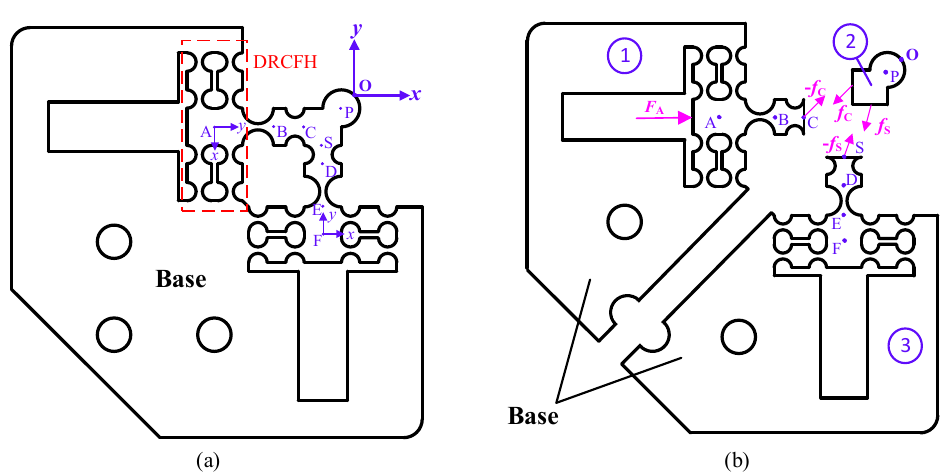
Figure 7. ( a ) Coordinate calibration of the compliance mechanism, and ( b ) the divided flexure hinge mechanism and its force analysis.